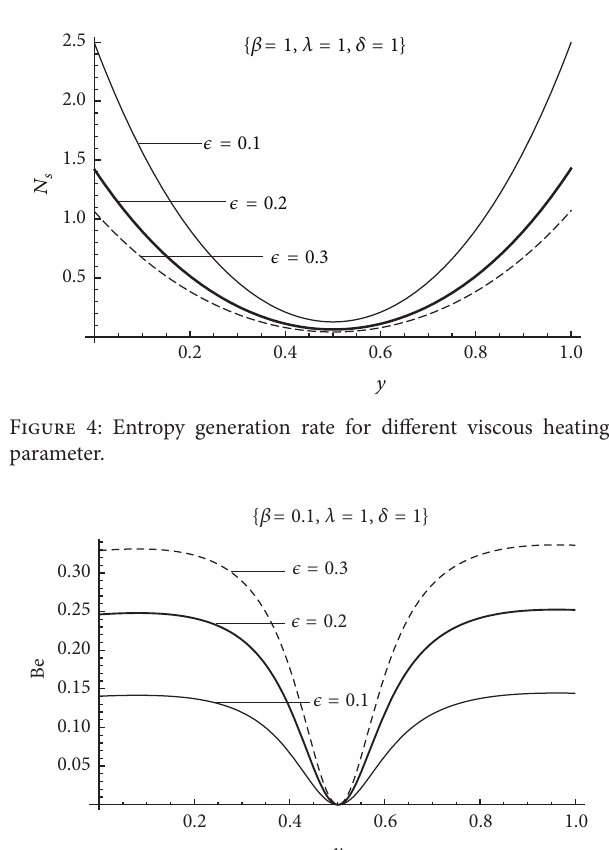
Figure 6: Bejan number at different porosity permeability parame- ter.